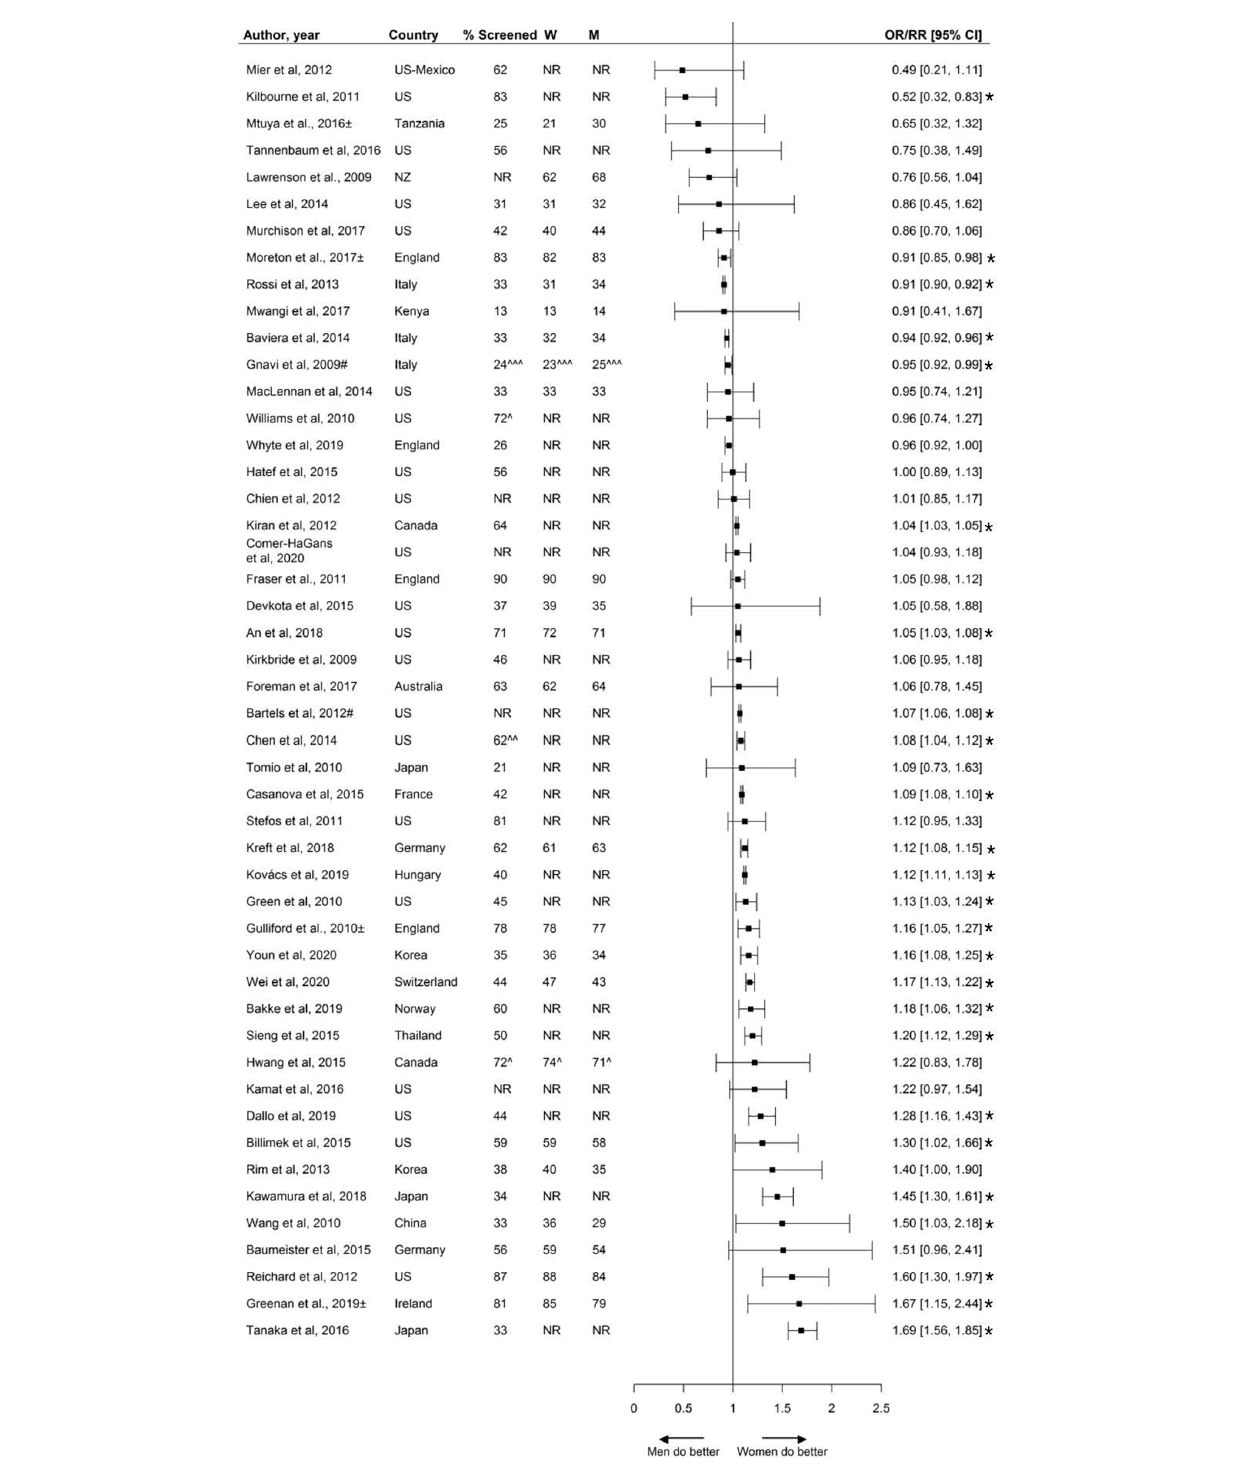
FIGURE 7 | Retinopathy screening, expressed as adjusted odds ratios (OR) or relative risks (RR) with corresponding 95% con fi dence intervals (CI). Two studies are not presented in this fi gure because of their measure of association: Swietek et al. (33): Average Marginal Effect, (SE; p-value): 0.017 ( − 0.0043; <0.01 (women more likely to receive screening), Du et al. (92): Prevalence difference (95% CI): 12.6 (4.1;21.2). W = % of screened women; M = % of screened men; US, United States; UK, United Kingdom; # = Relative risk; ^ = 662 weighted %; ^^ = assumed to be weighted %; ^^^ = Kaplan-Meyer estimate; ± = Studies assessing screening adherence after screening invitation. Men = reference. * = statistically signi fi